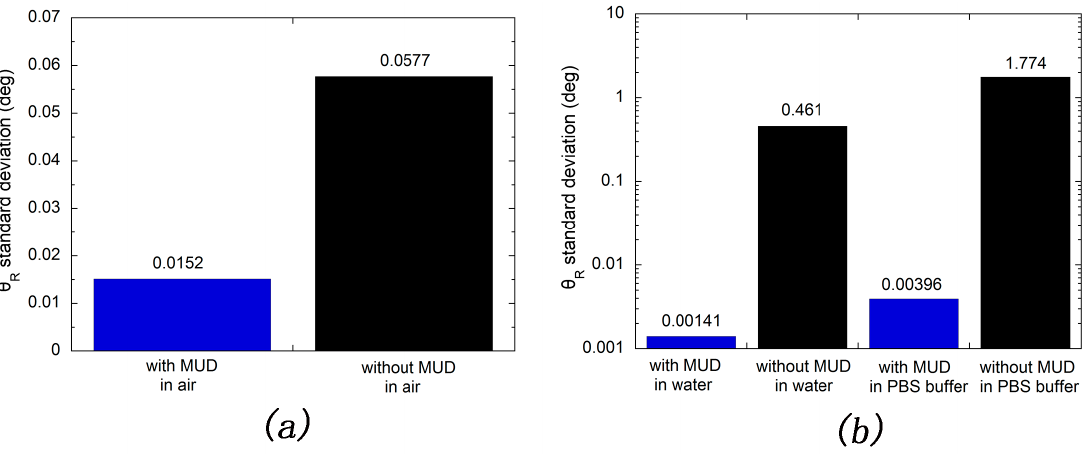
Figure 5. Standard deviations of resonance angle for tests of stability. ( a ) Long-term stability test; ( b ) Continuous stability test.